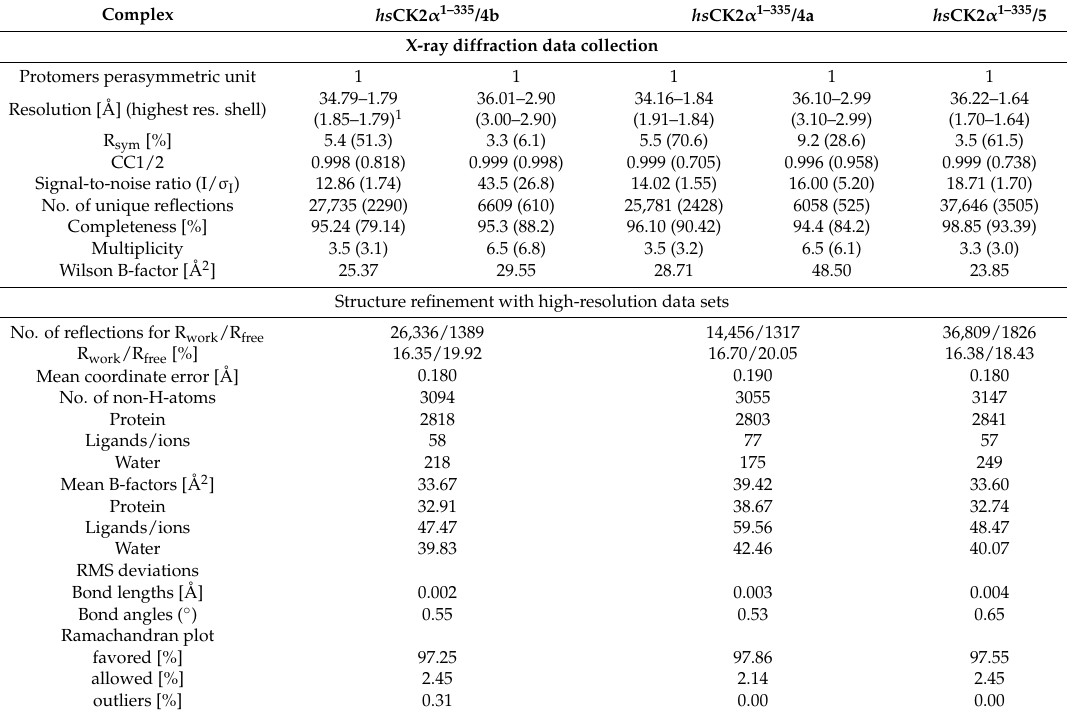
Table 4. X-ray diffraction data collection and refinement